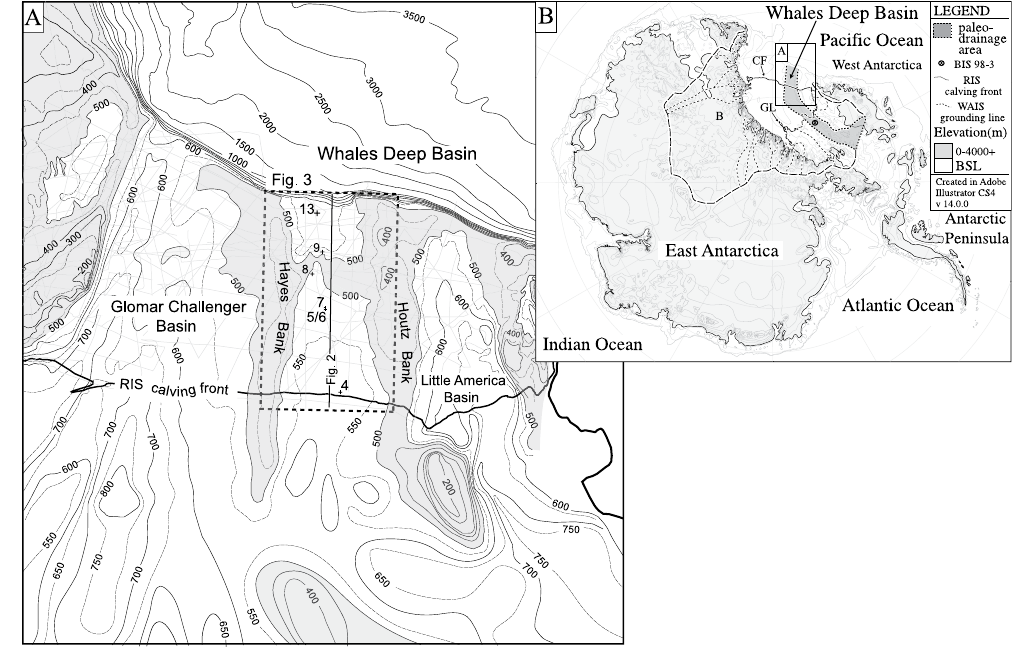
Figure 1. ( A ) Bathymetry of eastern Ross Sea 7, 8 (CI = 50 m). The light-gray rectilinear grid shows the seismic grid. The bold line shows the location of the seismic line shown in Fig. 2. The dashed box shows the location of Fig. 3. ( B ) The dark gray shade shows the drainage area for the paleo-Bindschadler Ice Stream when grounded ice advanced to the outer shelf 9, 10 superimposed on an elevation map of Antarctica 11 . The circled × marks the location of borehole Site 98–3 2 . The long- and short-dashed lines show ice sheet drainage and sub-drainage divides for Ross Sea. RIS = Ross Ice Shelf; GL = Grounding line; CF = Calving front. B = Byrd glacier drainage area.